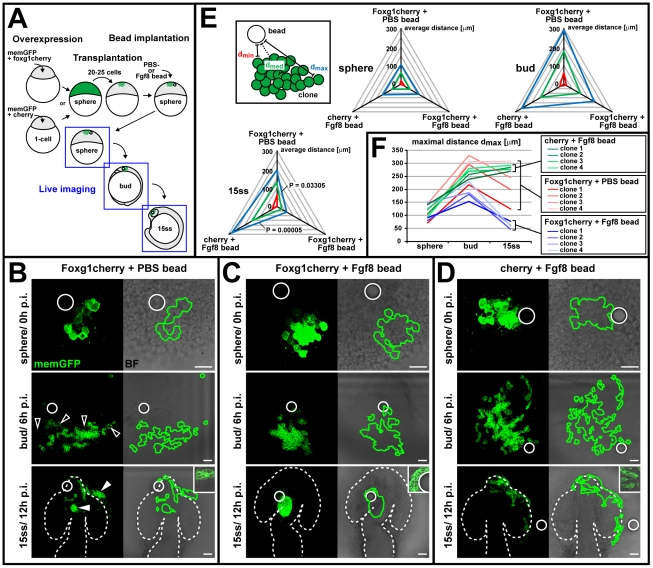
Foxg1 mediates cell cohesion in an Fgf-dependent manner.(A) Schematic of the overexpression-cell-transplantation-bead-implantation assay to test for an Fgf-dependent effect of foxg1 on cell cohesion by monitoring lateral cell spreading in live embryos. (B–D) Live images of horizontal cell spreading at sphere (0 h postimplantation [p.i.], top), bud (6 h postimplantation, middle), and 15ss (12 h postimplantation, bottom) from a representative clone overexpressing foxg1cherry in the presence of a PBS control bead (B), a clone overexpressing foxg1cherry in the presence of an Fgf8 bead (C), and a clone overexpressing cherry in the presence of an Fgf8 bead (D). Left: memGFP image (confocal z-projection), right: clone outline (green line), derived from memGFP image, superimposed with a bright-field (BF) image, showing bead localization (white circle). Dotted outlines: neural tube border. Insets in lower panels show cell morphology (bright-field image superimposed with a single confocal section of memGFP). Open arrowheads in (B): abnormal cells not included in tracking the clone outline. White arrowheads in (B): autonomous clustering of foxg1-overexpressing cells in the olfactory placode, head mesenchyme, and telencephalon. Scale bar: 50 µm. (E) Quantification of lateral cell spreading relative to the site of bead implantation. The maximal cell distance (d
max, blue) and the minimal distance from the bead surface (d
min, red) was measured (on projected z-stacks) and the median distance (d
med, green) calculated on the basis of d
max and d
min for four representative clones at sphere, bud, and 15ss. Radial plots of average d
max, d
min, and d
med values (in micrometers) at sphere, bud, and 15ss, (n = 4/stage) for foxg1cherry overexpression in the presence of a PBS control bead (top axis), foxg1cherry overexpression in the presence of an Fgf8 bead (right axis), and cherry overexpression in the presence of an Fgf8 bead (left axis). p-Values for 15ss stage derived by a paired, two-tailed t-test. (F) Line plots of single d
max values (in micrometers) over time (sphere, bud, 15ss) for four representative clones overexpressing foxg1cherry in the presence of a PBS control bead (red), overexpressing foxg1cherry in the presence of a Fgf8 bead (blue), and overexpressing cherry in the presence of a Fgf8 bead (green). Brackets indicate d
max value range at 15ss.